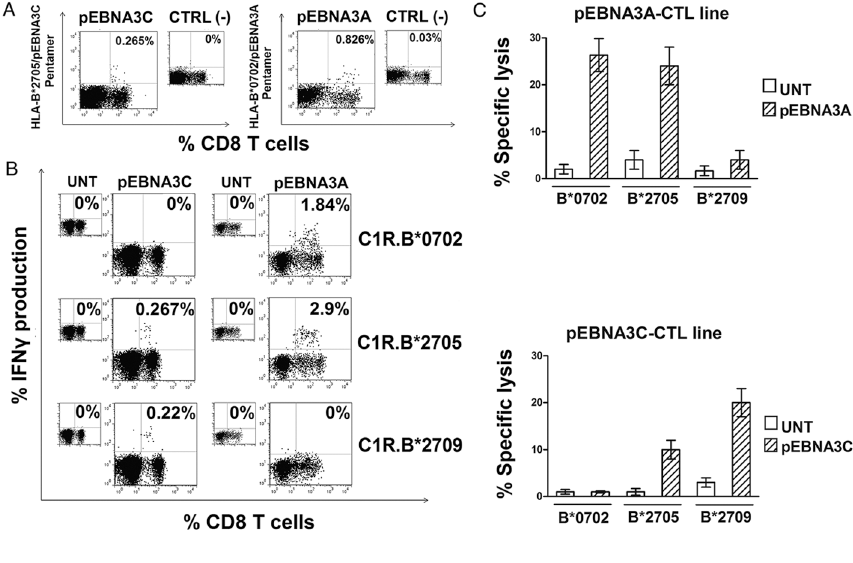
Figure 1. B*2705 can promiscuously present the B*0702-restricted EBNA3A epitope to CD8 + T cells from a B*2705/B*0702 positive AS patient (Don 1.05.07). (A) Flow cytometry plots for HLA-B*2705/pEBNA3C (left panel) and HLA-B*0702/pEBNA3A (right panel) pen- tamer staining within CD8 + T cells of PBMCs cultured for 12 d with pEBNA3C and pEBNA3A synthetic peptides (20 μ mol/L), respectively. Numbers indicate the percentage of pen- tamer-positive CD8 + T cells. Smaller panels show flow cytometry profiles of pEBNA3C- (left) or pEBNA3A-stimulated (right) PBMCs for staining with an irrelevant pentamer. (B) Detec- tion of intracellular IFN γ production by PBMCs stimulated with pEBNA3C or pEBNA3A for 14 d and then re-stimulated by the indicated, untreated or peptide-pulsed C1R trans- fectants (30 μ mol/L). Numbers represent the percentage of IFN γ -producing CD8 + T cells. (C) Assessment of cytotoxicity by representative pEBNA3A- (top) and pEBNA3C- (bottom) stimulated CTL lines against HLA-B*0702, -B*2705, -B*2709 C1R transfectants used as target cells. E/T ratio was 20:1. Bars represent the mean percentage of specific lysis ± SEM of three separate